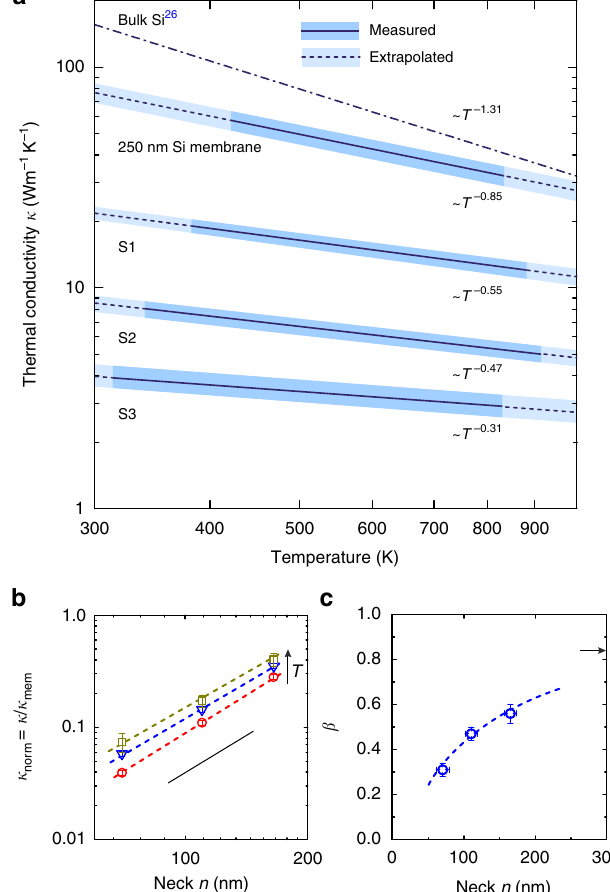
Fig. 3 Temperature dependence of the thermal conductivity. a Thermal conductivity of porous membranes (S1, S2 and S3) and 250 nm thick membrane as a function of temperature. Solid and dashed lines denote measured and extrapolated κ , respectively. The shaded areas indicate experimental uncertainty derived in Methods Section. b Normalised thermal conductivity of porous membranes as a function of the neck size n for three example temperatures; circles — 300 K, triangles — 600 K, squares — 900 K. The error bars are experimental uncertainties of κ derived in Methods Section. The dashed lines are guides to the eye connecting data points of the same temperature. The solid line is a reference plot indicating n 2 dependence. c The exponent β governing the temperature dependence of κ as a function of the neck size n . The dashed line is a guide to the eye and the arrow indicates β of the 250 nm thick membrane. Horizontal and vertical error bars indicate the experimental uncertainties of β and n determined from the data fi t using Eq. (2) and from scanning electron microscope images,